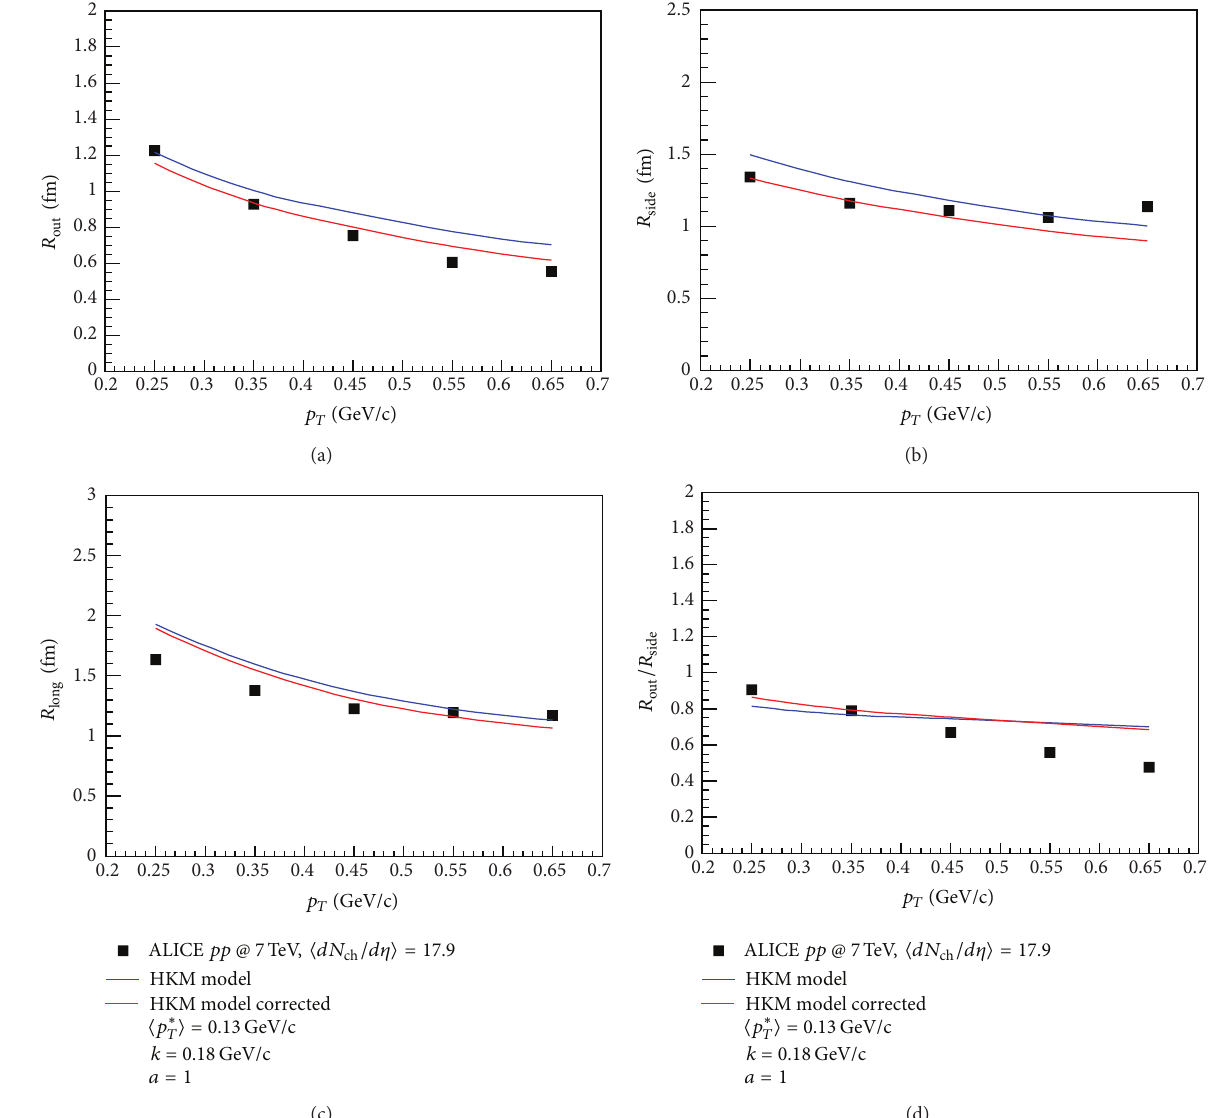
/𝑑𝜂⟩ = 17.9 . The data are taken from [42]. ch